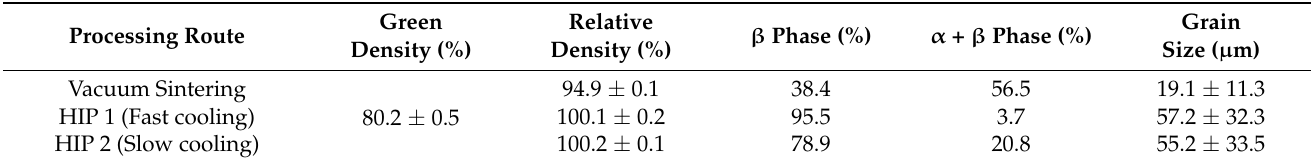
Table 2. Archimedes’ and metallographic characterization of the Ti35Nb2Sn alloy.